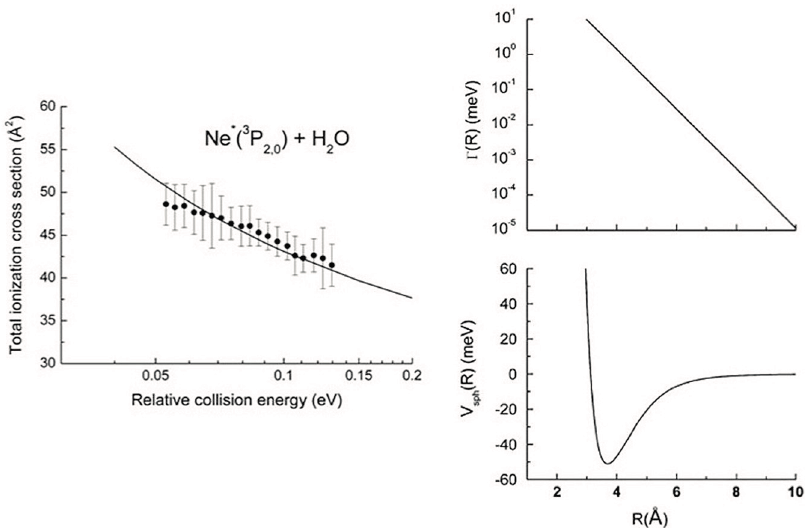
Figure 4. Left side: The total ionization cross-sections of the Ne * –H 2 O autoionizing collisions as a function of the relative collision energy. The curve represents the calculation of the cross-section by applying the theory defined in terms of the so-called optical potential model, which exploits the recorded energy shifts from the electron kinetic energy spectra to probe the main characteristics of the potential energy surface for the Ne * –H 2 O entrance channel (see the text and Figure 2) [14,15,22]. Right side: The spherical optical potential used for the cross-section calculation (see left side of this figure). Lower panel represents the real part of the optical potential, while the upper panel is the imaginary part (see the text and [23]).